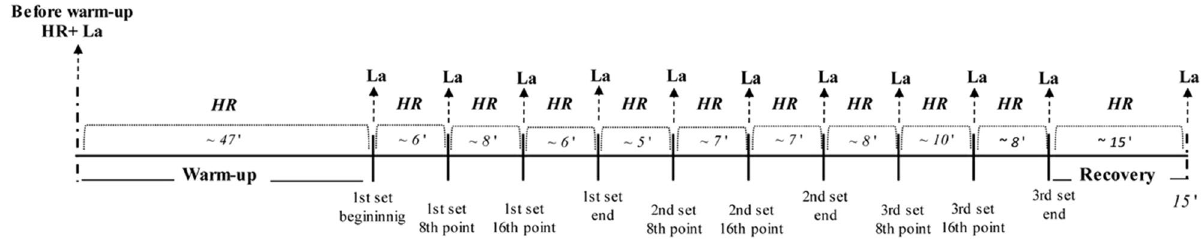
Figure 1. Timeline and data